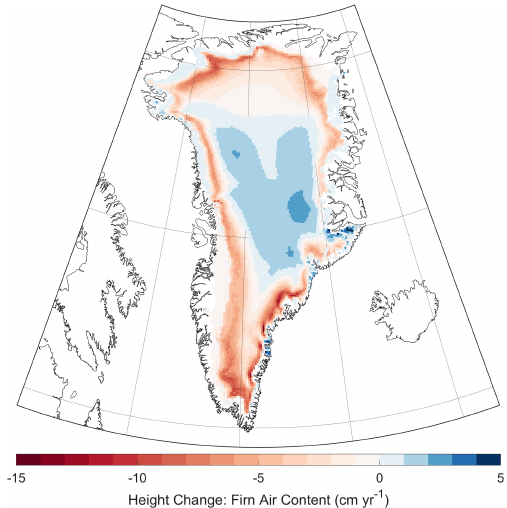
Figure 17. Rate of height change resulting from changes in firn air content over the Greenland Ice Sheet between 1 September 2003 and 1 September 2021. Note the asymmetric color